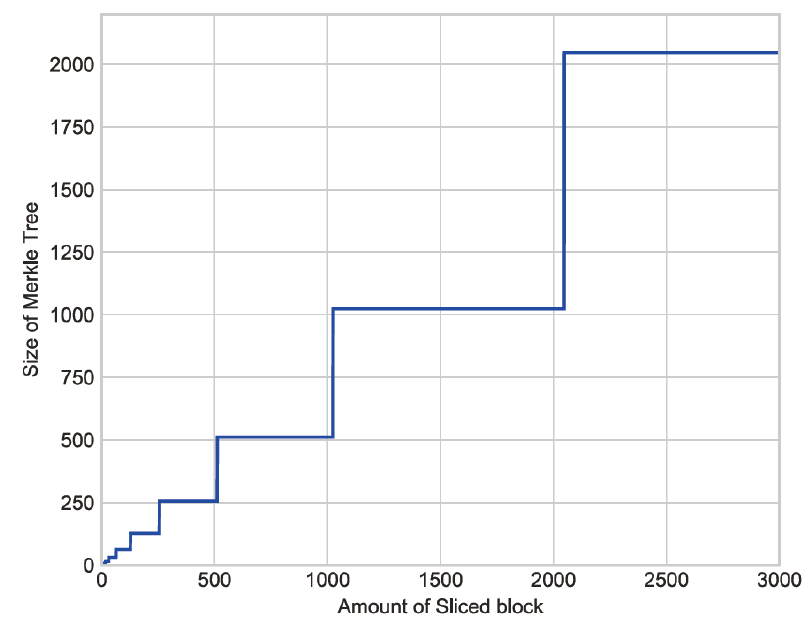
Figure 20. The size of Merkle tree in different amounts of sliced